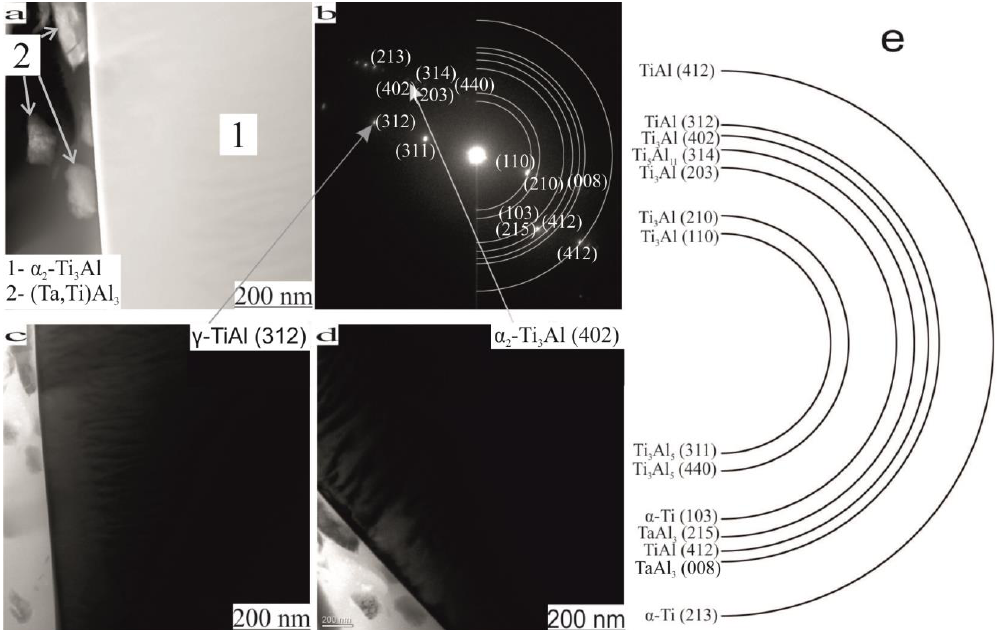
Figure 9. Electron microscope images of the TAT alloy: ( а) bright-field image; ( b) microdiffraction pattern; ( c) dark-field image in reflex; ( d) microdiffraction pattern identification.